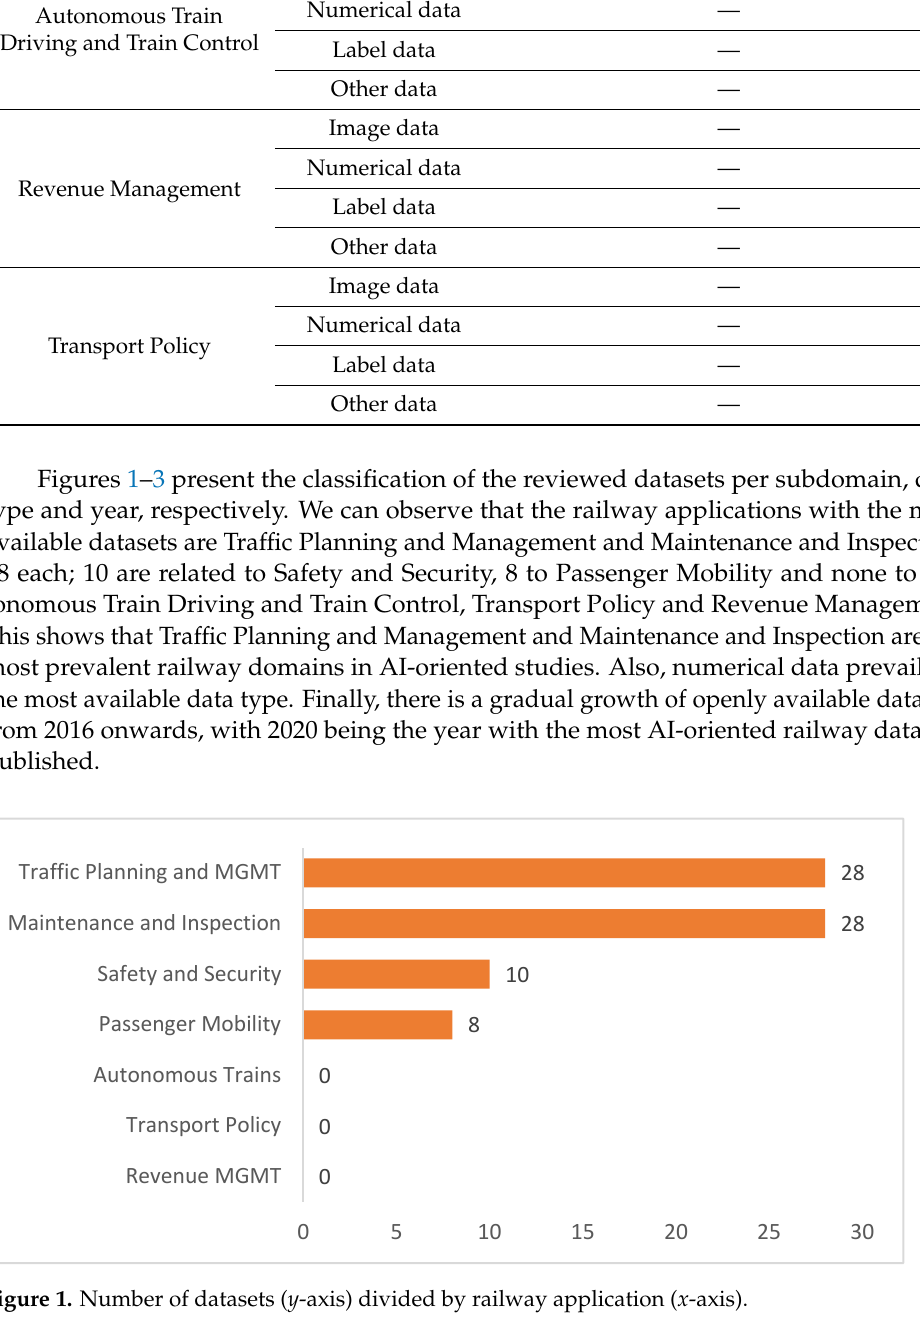
Figure 2. Number of datasets (y-axis) divided by data type (x-axis).